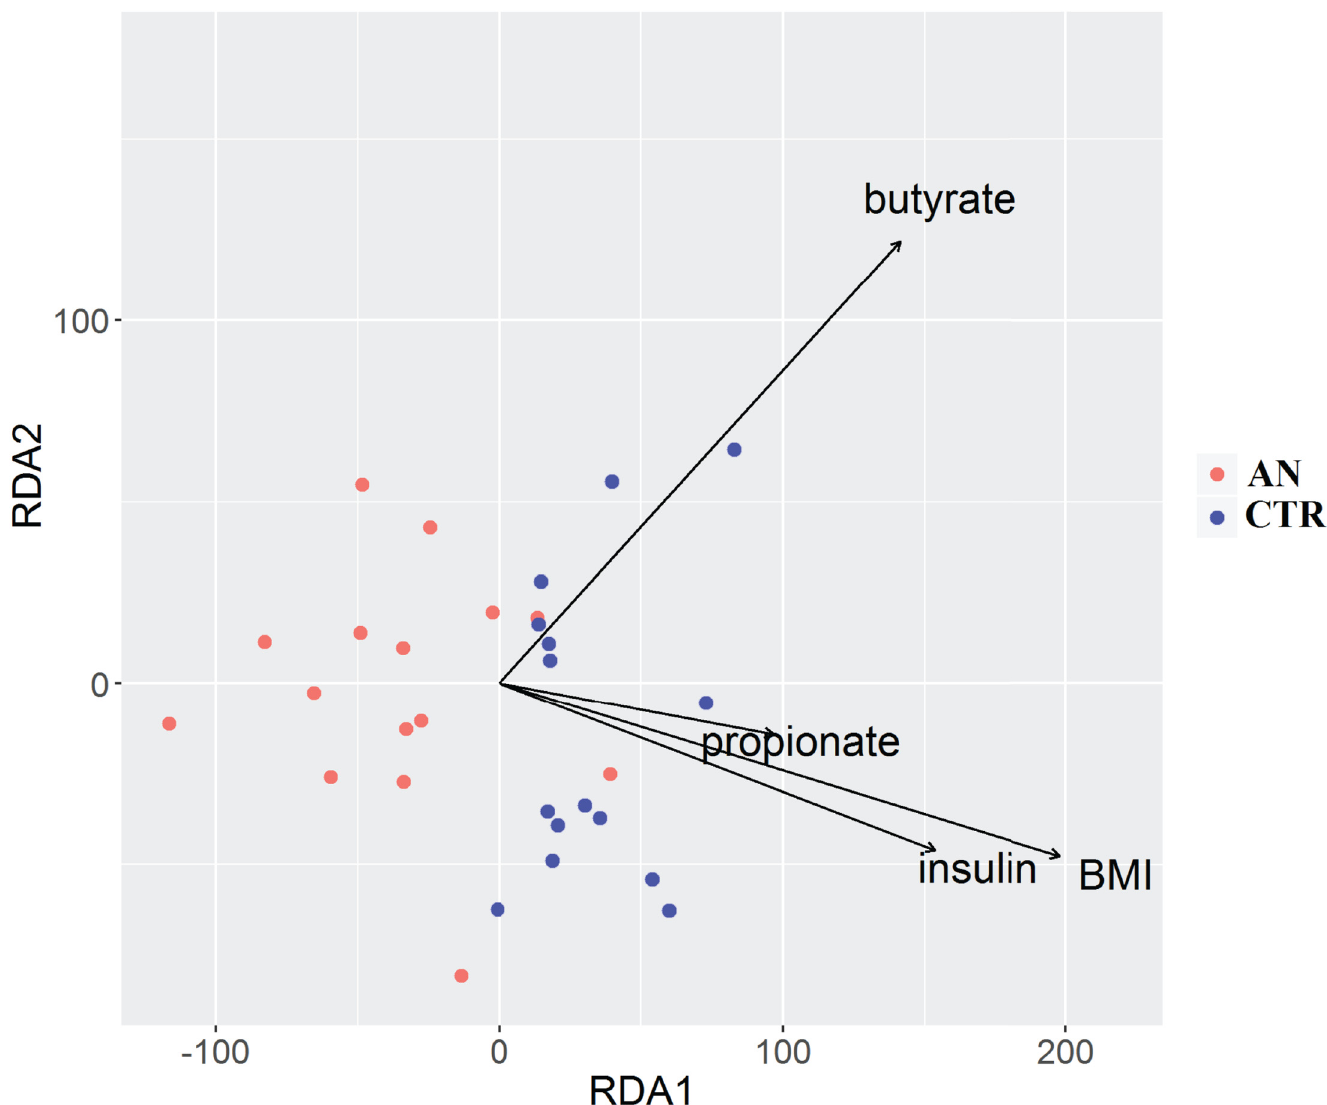
Fig 3. Distance-based redundancy analysis (db-RDA). Db-RDAplot shows correlations betweengut microbiotacompositionand body mass index (BMI), insulin, propionateand butyrate. Only significantvariables are represented(p > 0.05,Permanova analysis).Arrows in the db-RDA biplot denote the magnitudesand directions of the variableeffects. Controls are represented by blue dots and anorexic subjectsby red dots.